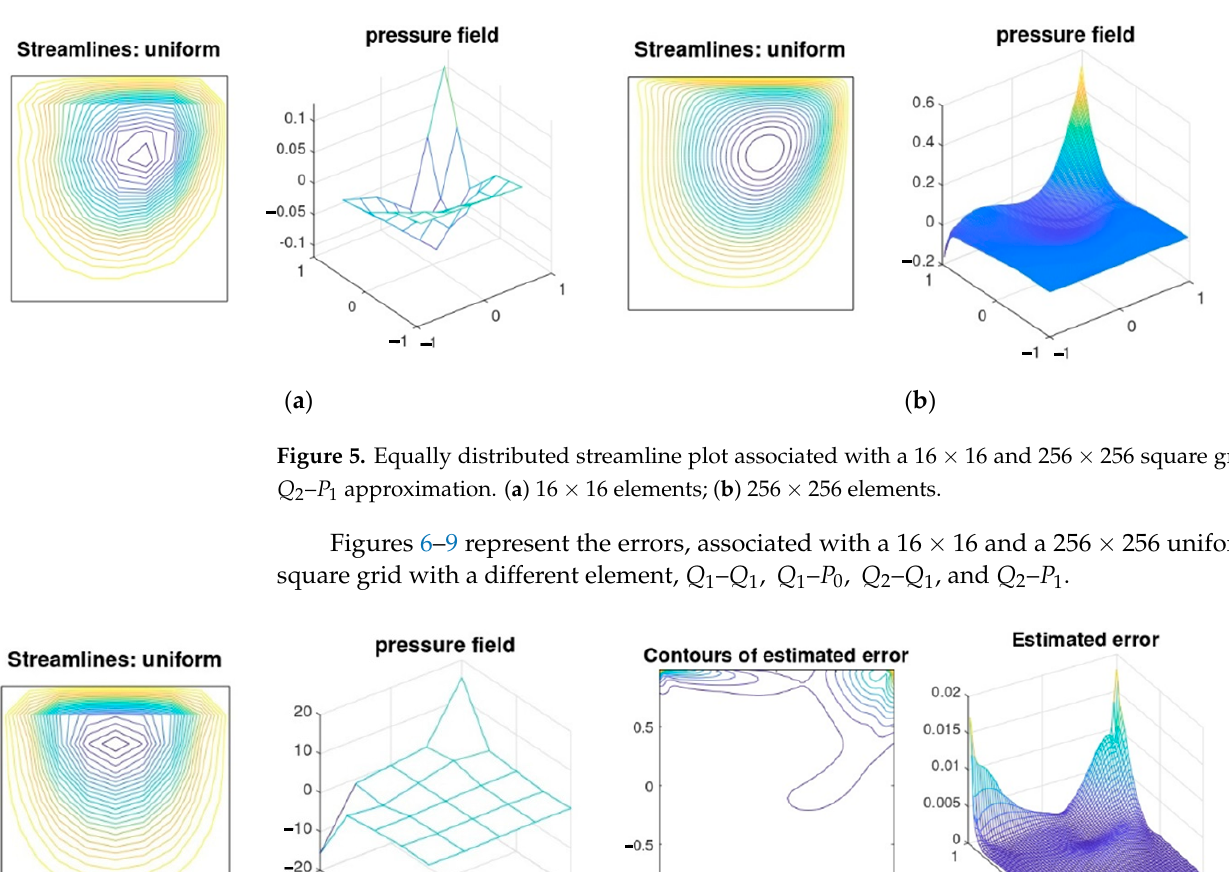
Figure 4. Equally distributed streamline plot associated with a 16 × 16 and 256 × 256 square grid, 𝑄 (cid:2870) – 𝑄 (cid:2869) approximation. ( a ) 16 × 16 elements; ( b ) 256 × 256 elements.